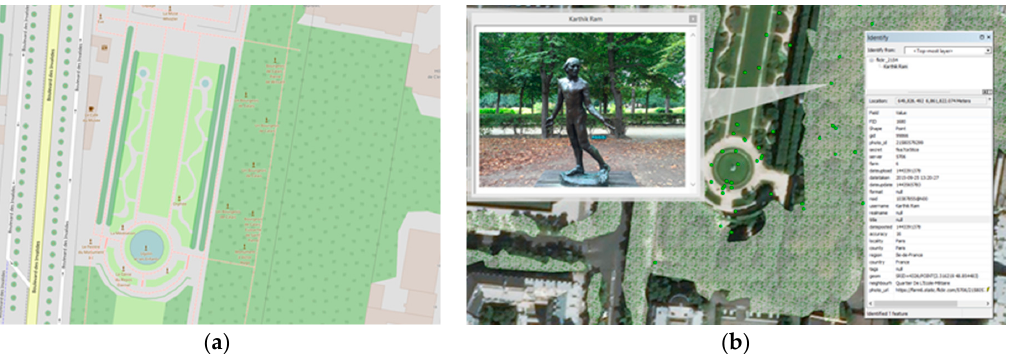
Figure 15. The use of Flickr photographs to verify OSM POIs. ( a ) OSM map for an area in Paris with POIs that are under trees; ( b ) the same area with the IGN polygons of the wooded areas and the position of geo-tagged Flickr photographs. A Flickr photograph is shown in a pop-up as well as additional attributes provided by the photographer (©OpenStreetMap contributors, ©IGN).